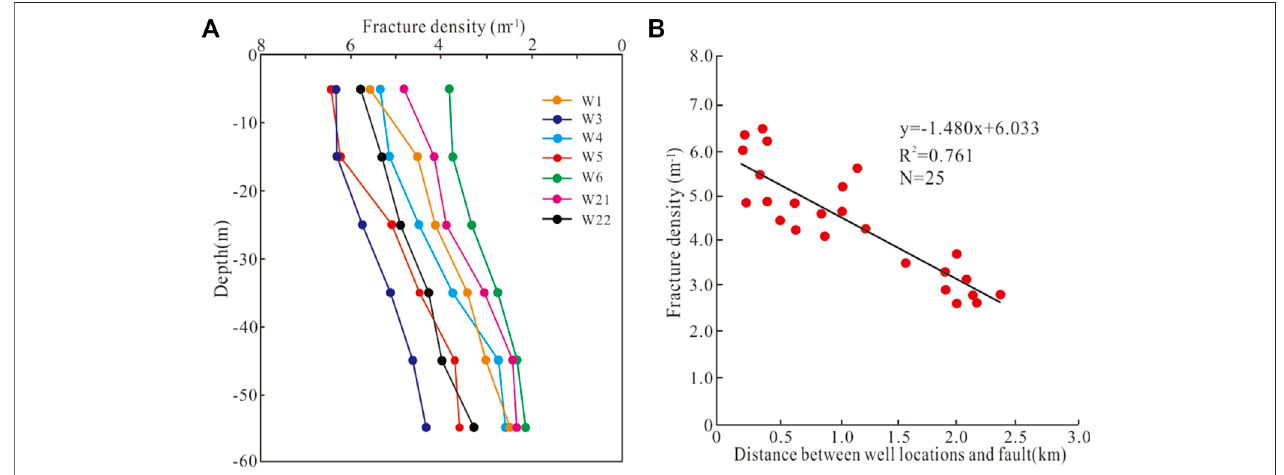
FIGURE 6 | Distribution characteristics of bedrock fractures. (A)Fracture density varies with depth (data from FMI, and the point 0 is at the top of semi-weathered unit). (B) Relationship between fracture density and distance between well points and fault (data from FMI and cores).